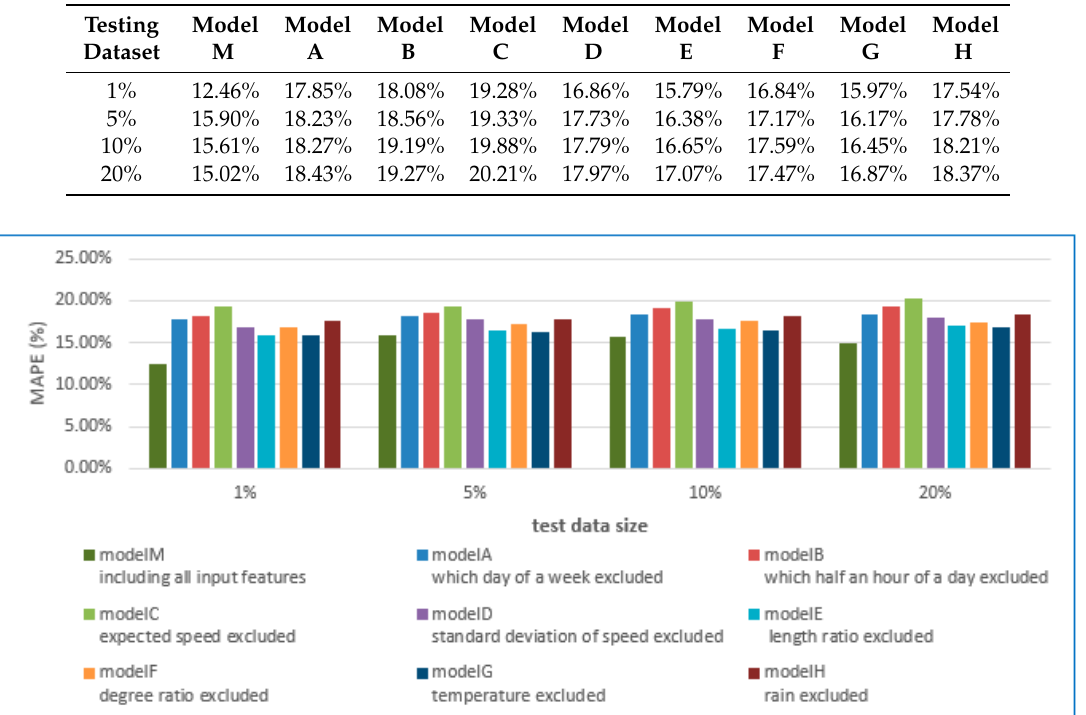
Table 11. MAPE of ANN with some influence factors excluded.